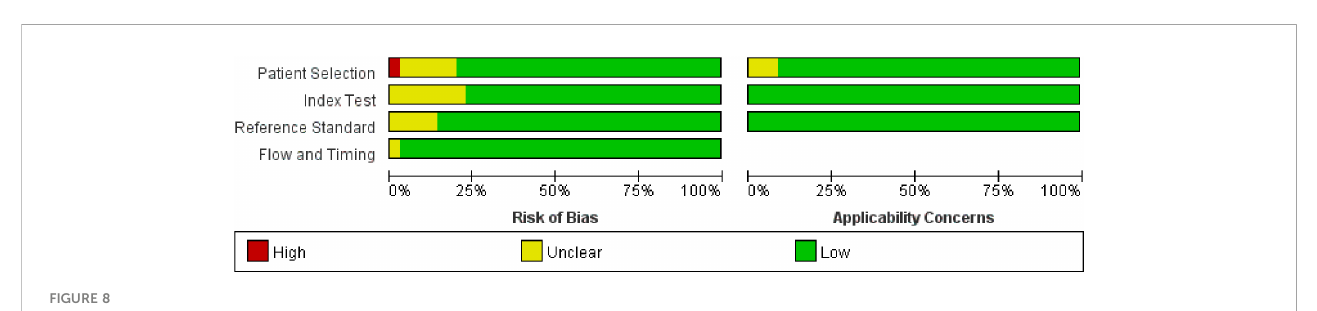
FIGURE 8 Literature quality evaluation of group B.